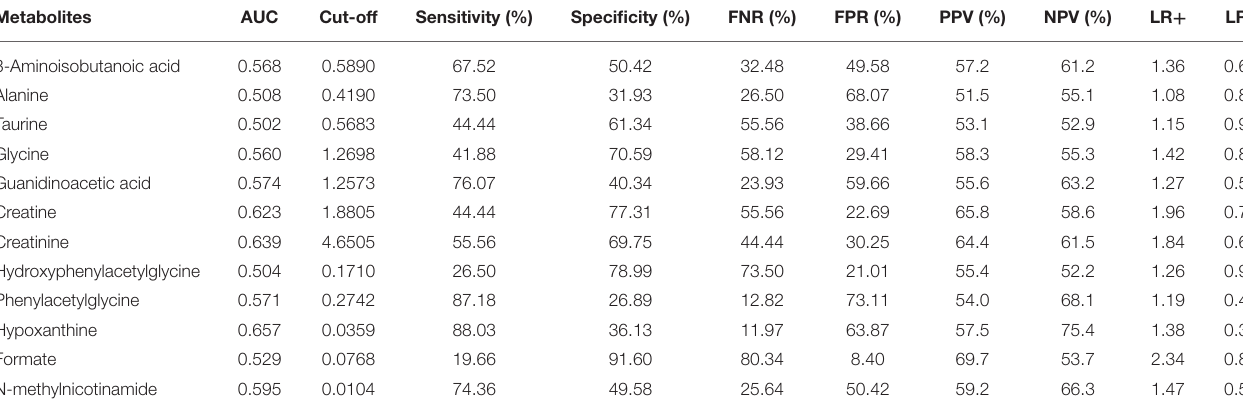
TABLE 3 | Diagnostic accuracies of differential metabolites between the ASD and control